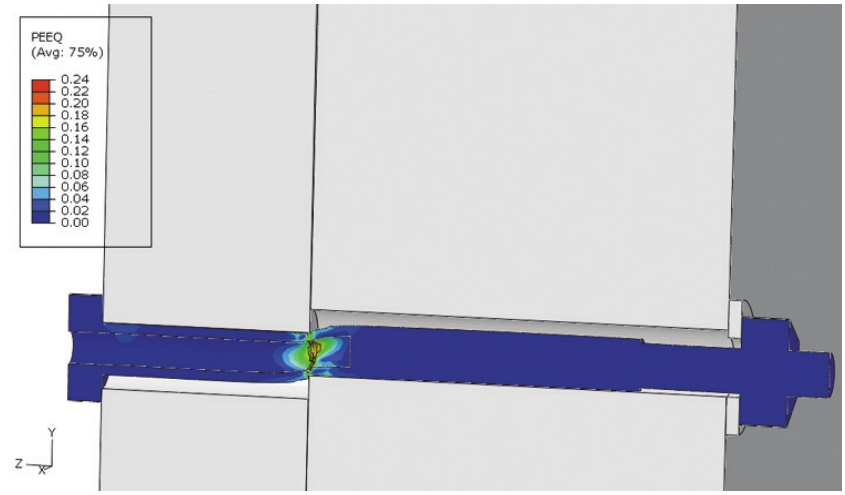
Fig. 18. Contours of equivalent plastic strain, dynamic shear model, t = 22